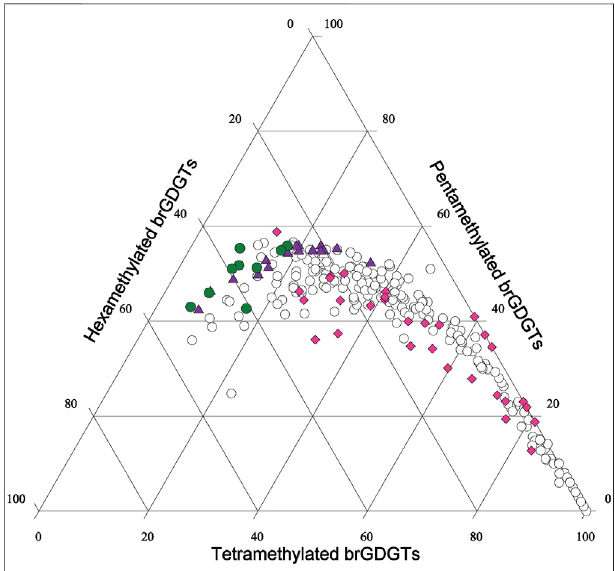
FIGURE2| Relativeabundanceoftetramethylene,pentamethylene,and hexamethylene in branched glycerol dialkyl glycerol tetraethers (brGDGTs). The green circles correspond to soils used in this article. The purple triangles correspond to soils from the northeastern Tibetan Plateau reported by WangandLiu,2021,andthepinksoliddiamondscorrespondtosoilsfromthe northeastern Tibetan Plateau reported by Chen et al. (2019). The solid white circles correspond to global soils reported by De Jonge et al.